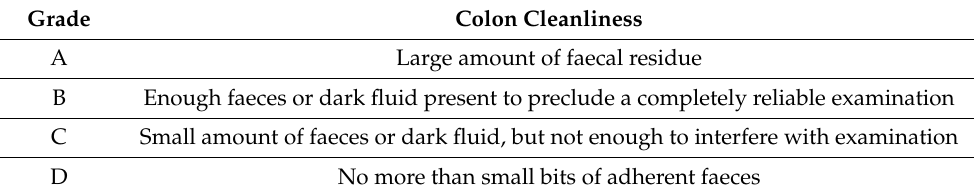
Table 1. Grading of bowel